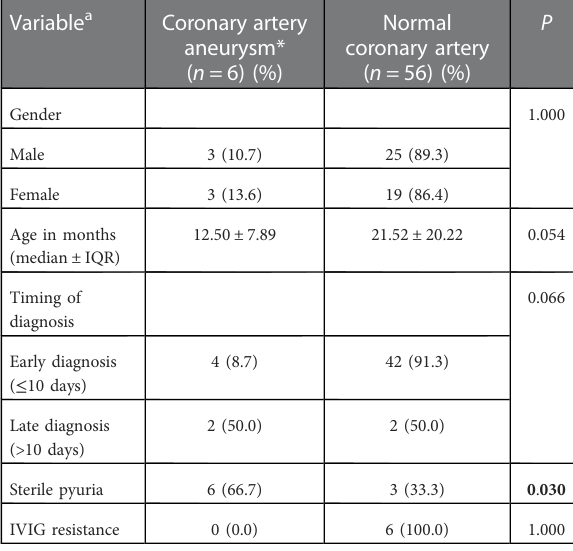
TABLE 3 Univariate analysis of risk factors for coronary artery aneurysm. Variable